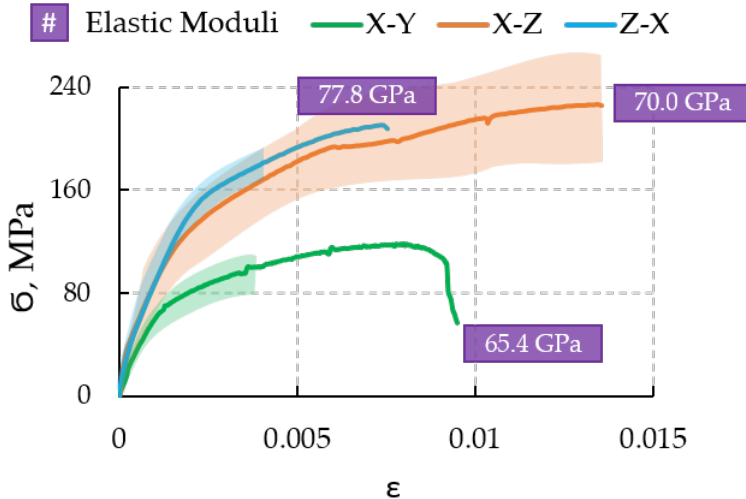
Figure 11. The typical stress–strain curves obtained for different sample printing orientations with the Young’s modulus also indicated. Table 1. Mechanical performance of RS-333 alloy samples with different sample orientations. Sample